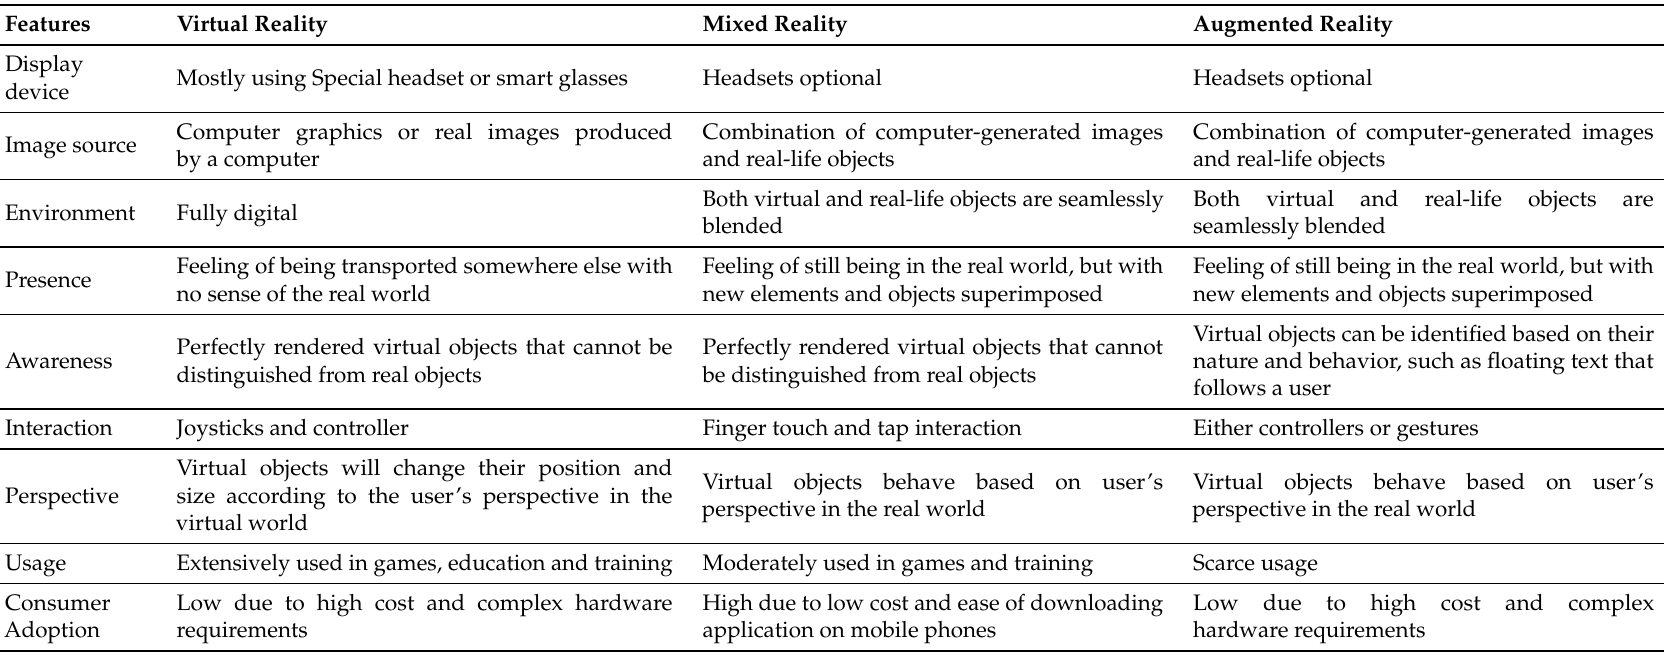
Table 1. Comparison according to three key space specifications (Adopted from